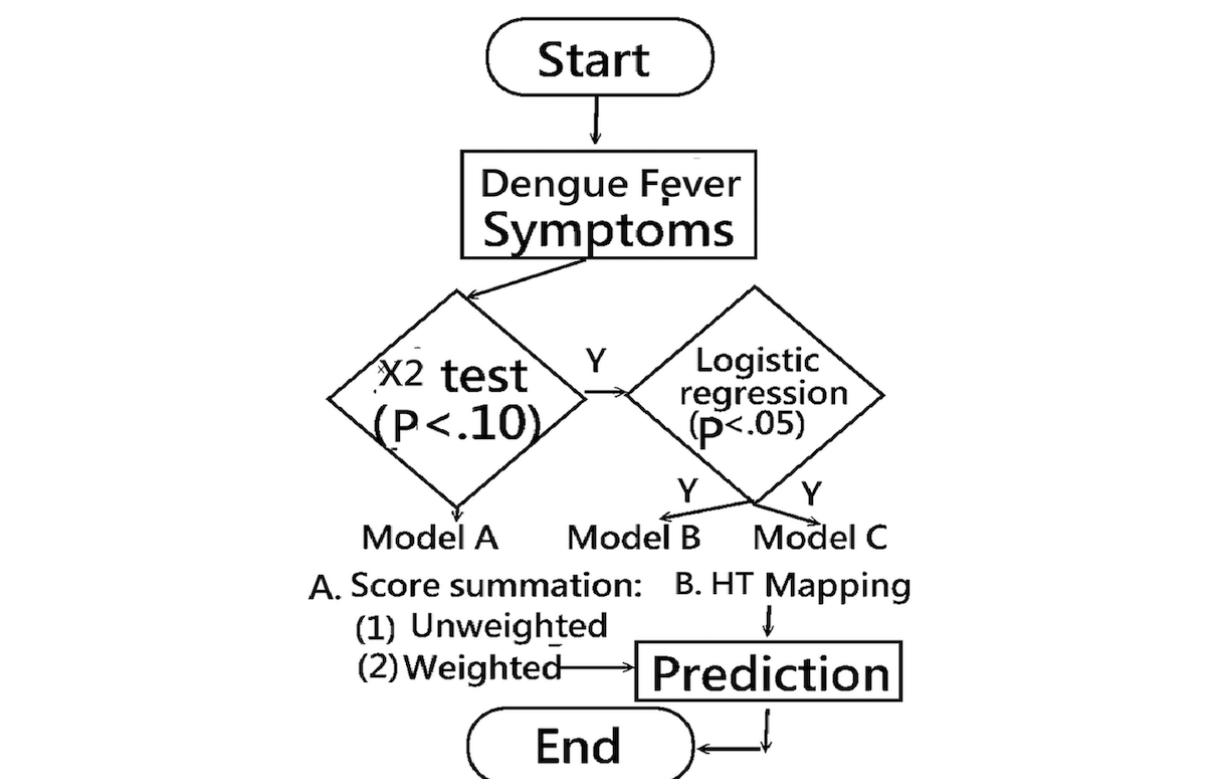
Figure 2. Overall study concept and the flow